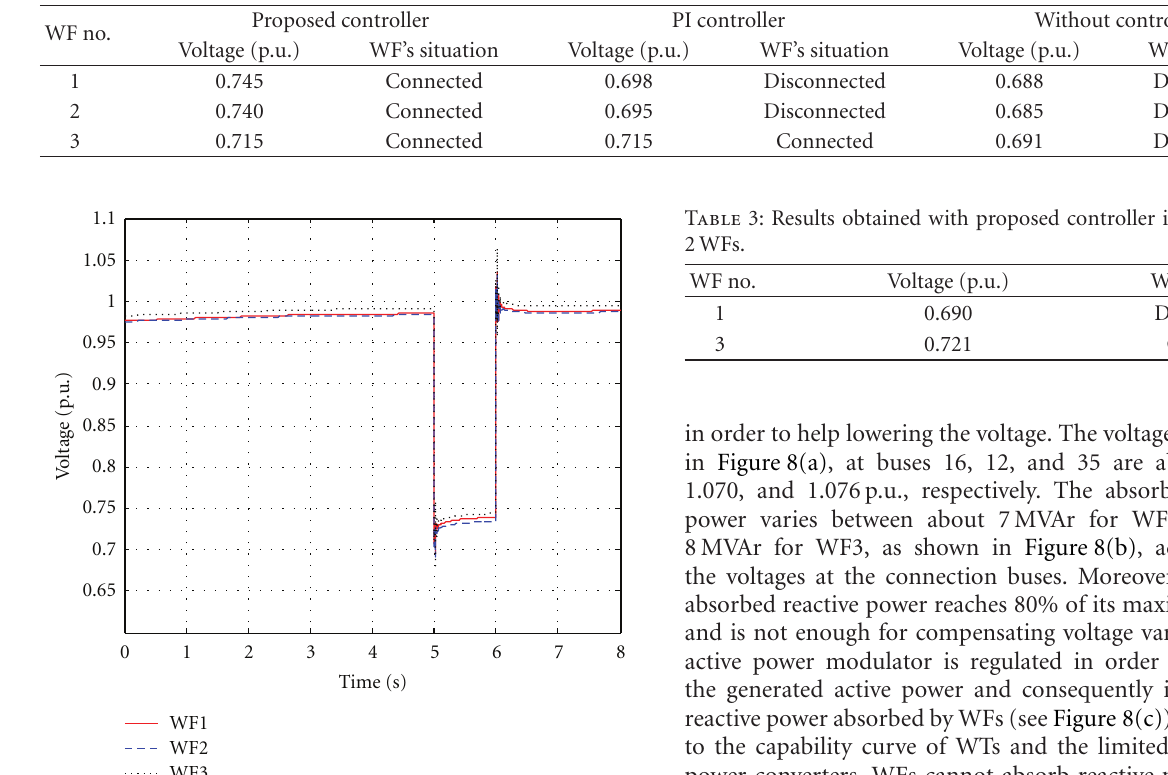
Table 2: Results obtained with PI controller and without controller for all WFs.